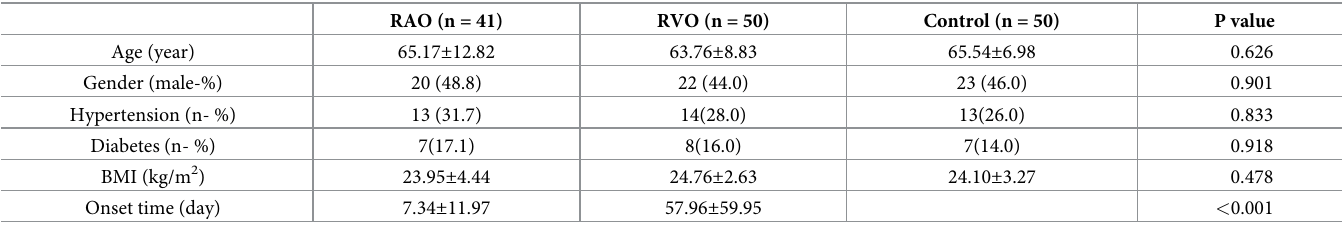
Table 2. Baseline characteristics of participants.